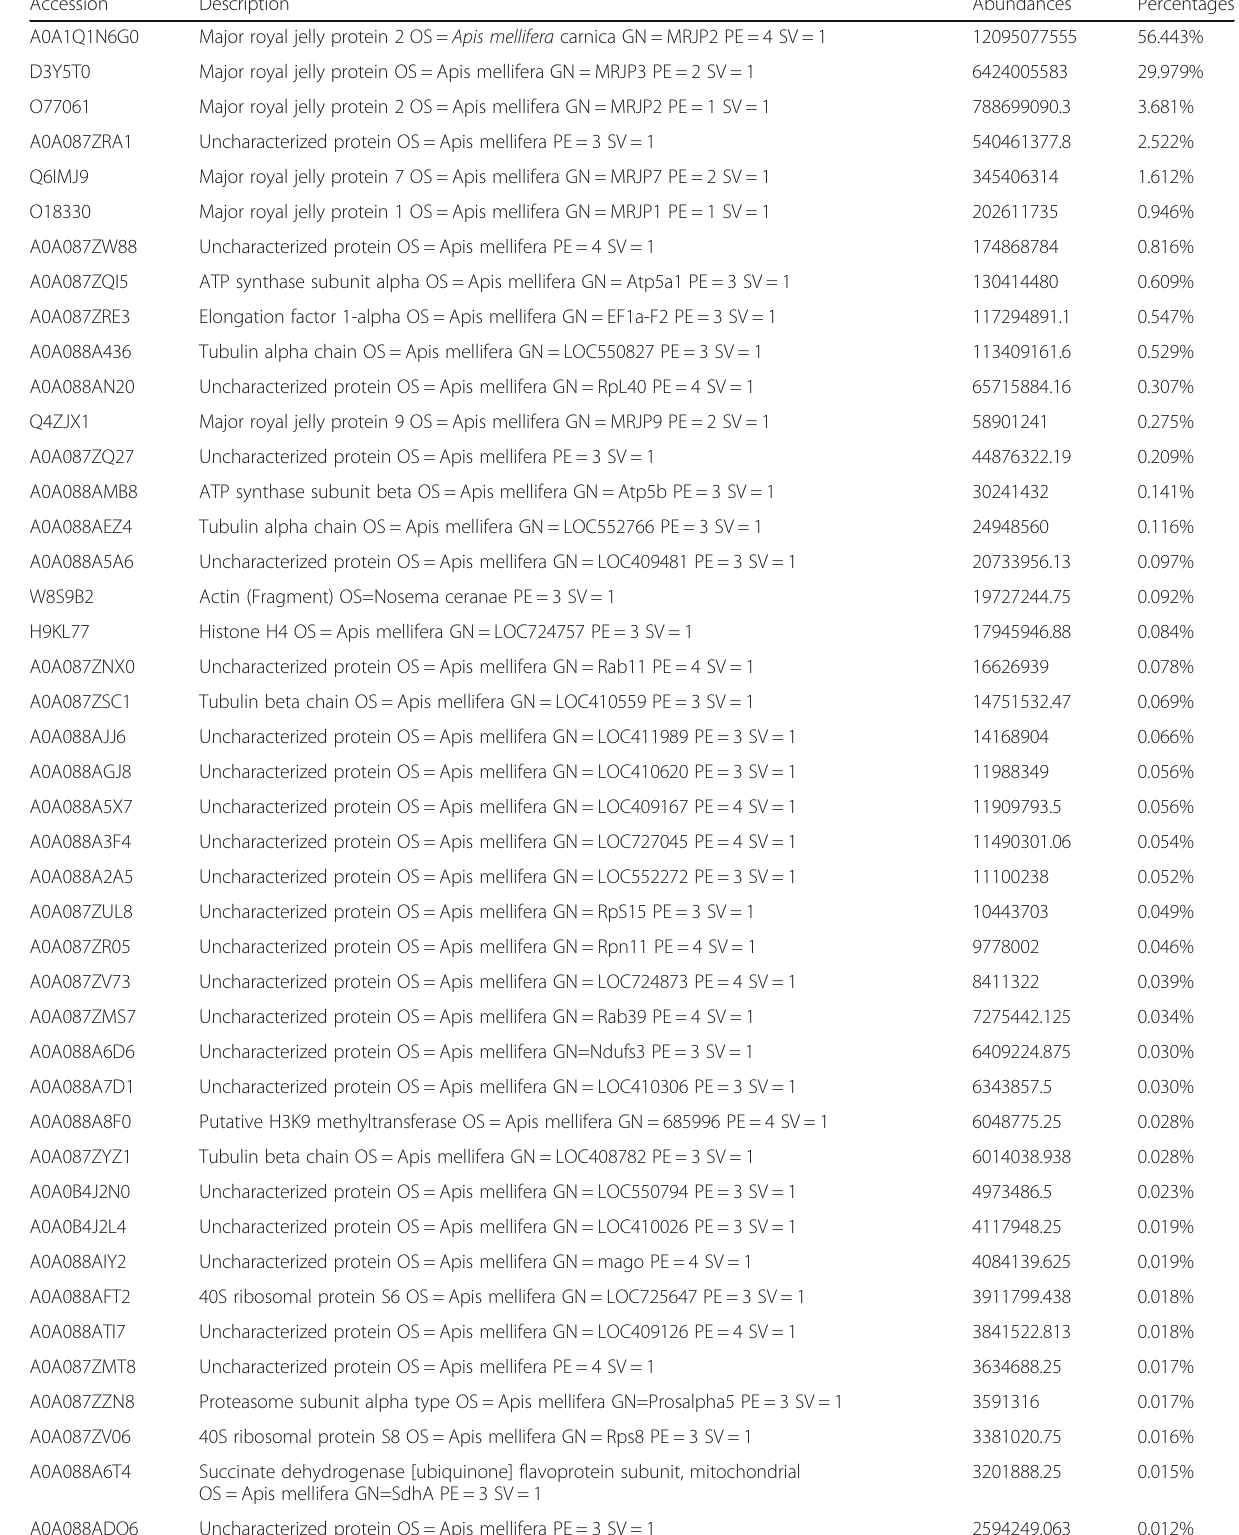
Table 1 Identification and quantification of proteins in Fraction 2